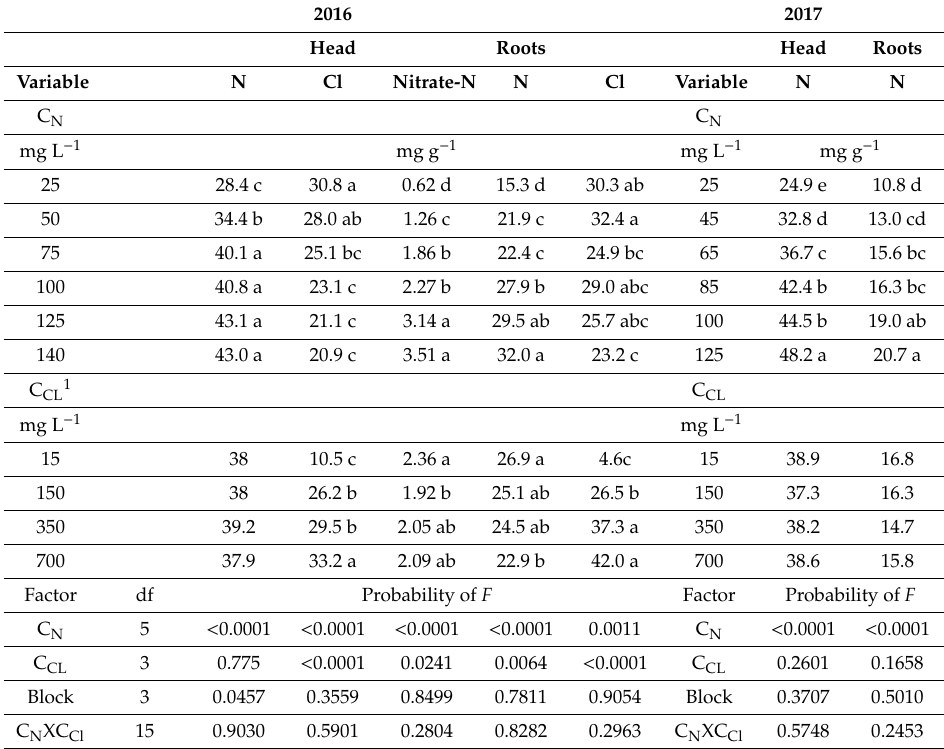
Table 6. The e ff ect of C N and C CL on N, Cl, and nitrate-N concentrations in lettuce head and roots. The probability of F values for C N , C Cl , Block factors, and the interaction of C N and C Cl was determined using the two-way ANOVA procedure of JMP 14. Di ff erent letters on the right side of values indicate significant di ff erence between treatments (HSD) at p < 0.05 by the Tukey–Kramer honestly test. No letters are presented when no significant di ff erence was